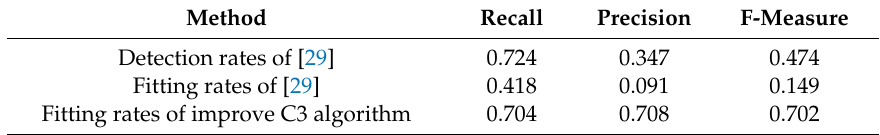
Table 1. Comparison of the average detection rates and fitting rates among different methods.